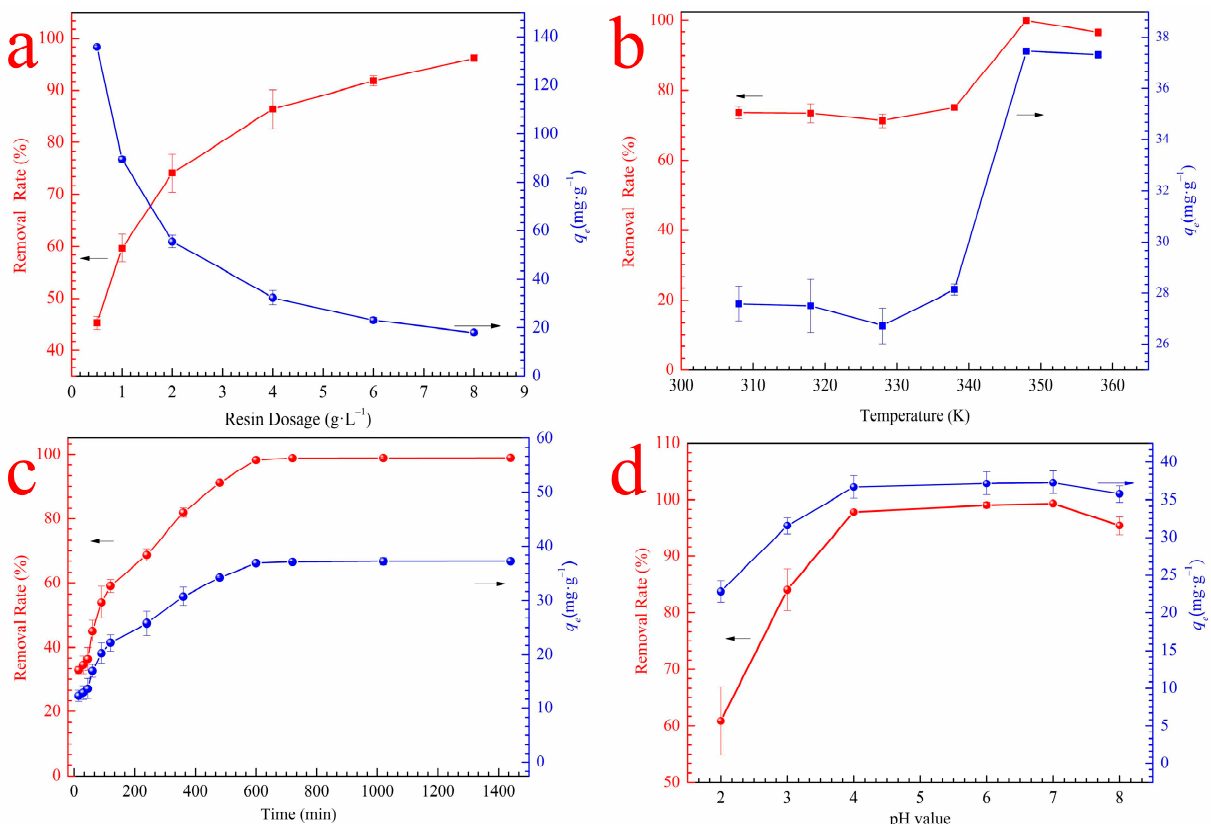
Figure 2. The adsorption effect of calcium ions adsorbed by RMCRs as a function of adsorbent dosage ( a ), temperature ( b ), contact time ( c ), and pH value of RMCRs ( d ).